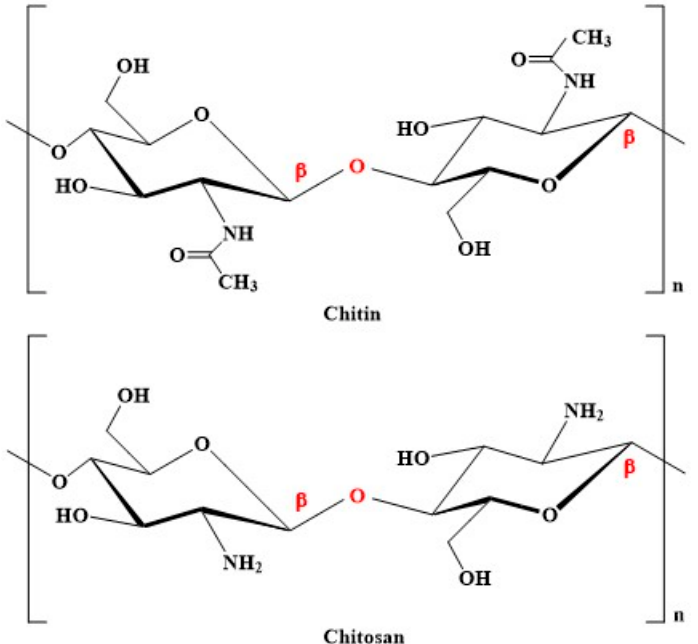
Figure 1. Structure of chitin and chitosan. Chitosan can be prepared upon deacetylation of chitin. The degree of deacetylation can be represented as the molar fraction of GlcN (x) and GlcNAc (100- ×) units. When the degree of chitin deacetylation is more than 50%, it is called chitosan. N-acetylated glucosamine: GlcNAc; 2-amino-2-d-glucose: GlcN. The degree of deacetylation (DD) is the ratio of the relative number of D-glucosamine units to the cumulative number of N-acetyl-D-glucosamine and D-glucosamine units